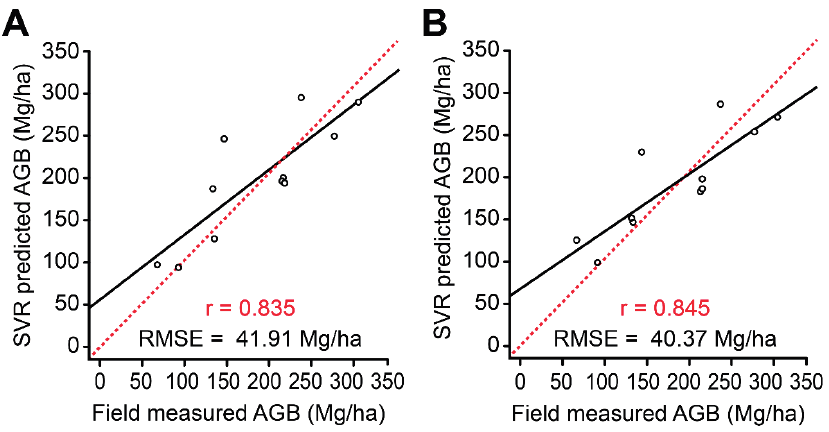
Figure 7. SVR-predicted AGB vs. field-measured AGB, as derived from Google Earth™ imagery via the FOTO method using ( A ) HCV and VCH, and ( B ) TV only. Solid black lines represent regression lines; red dashed lines represent 1:1 correspondence